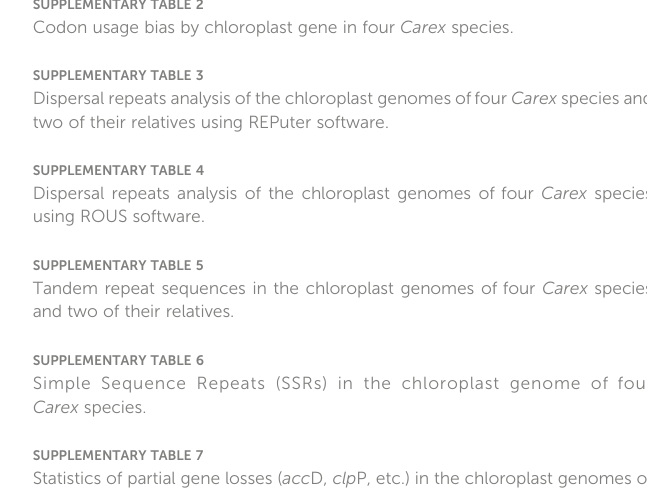
and two of their relatives. SUPPLEMENTARY TABLE 6 Simple Sequence Repeats (SSRs) in the chloroplast genome of four Carex species. SUPPLEMENTARY TABLE 7 Statistics of partial gene losses ( acc D, clp P, etc.) in the chloroplast genomes of all species involved in this